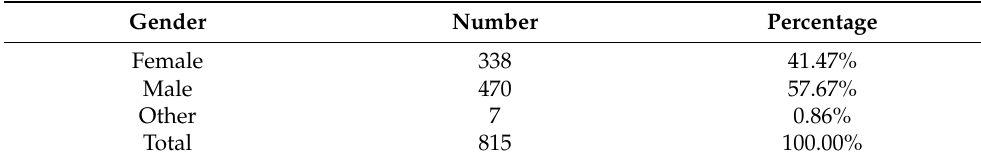
Table 3. Gender distribution of the sample.